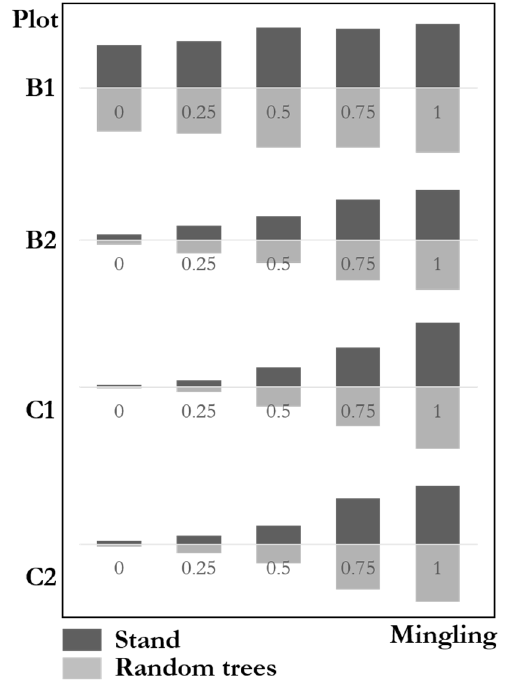
Figure 10. Mingling degree distributions of stands and random trees.